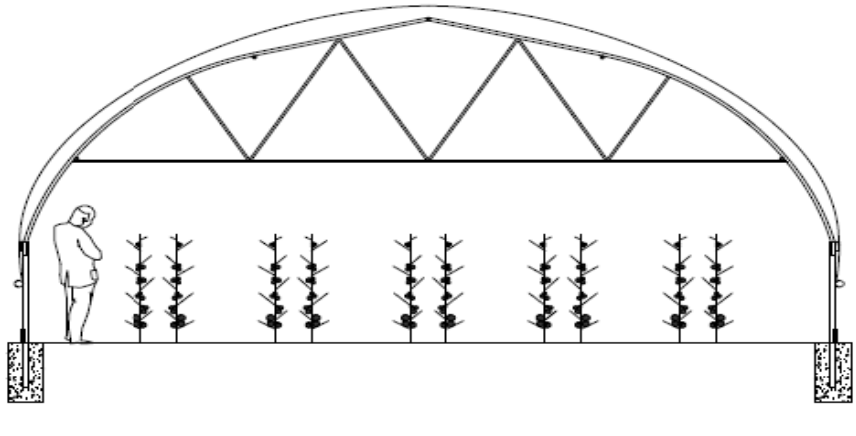
Figure 2. Functional greenhouse.